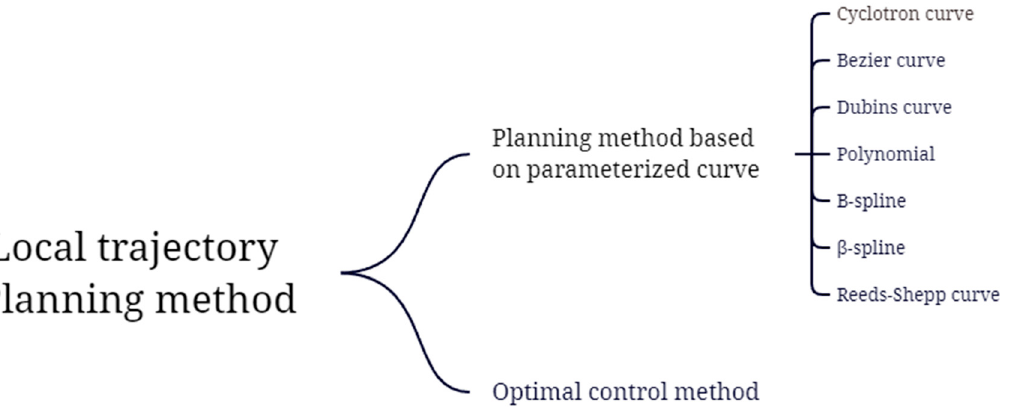
Figure 1. Classification of local trajectory planning